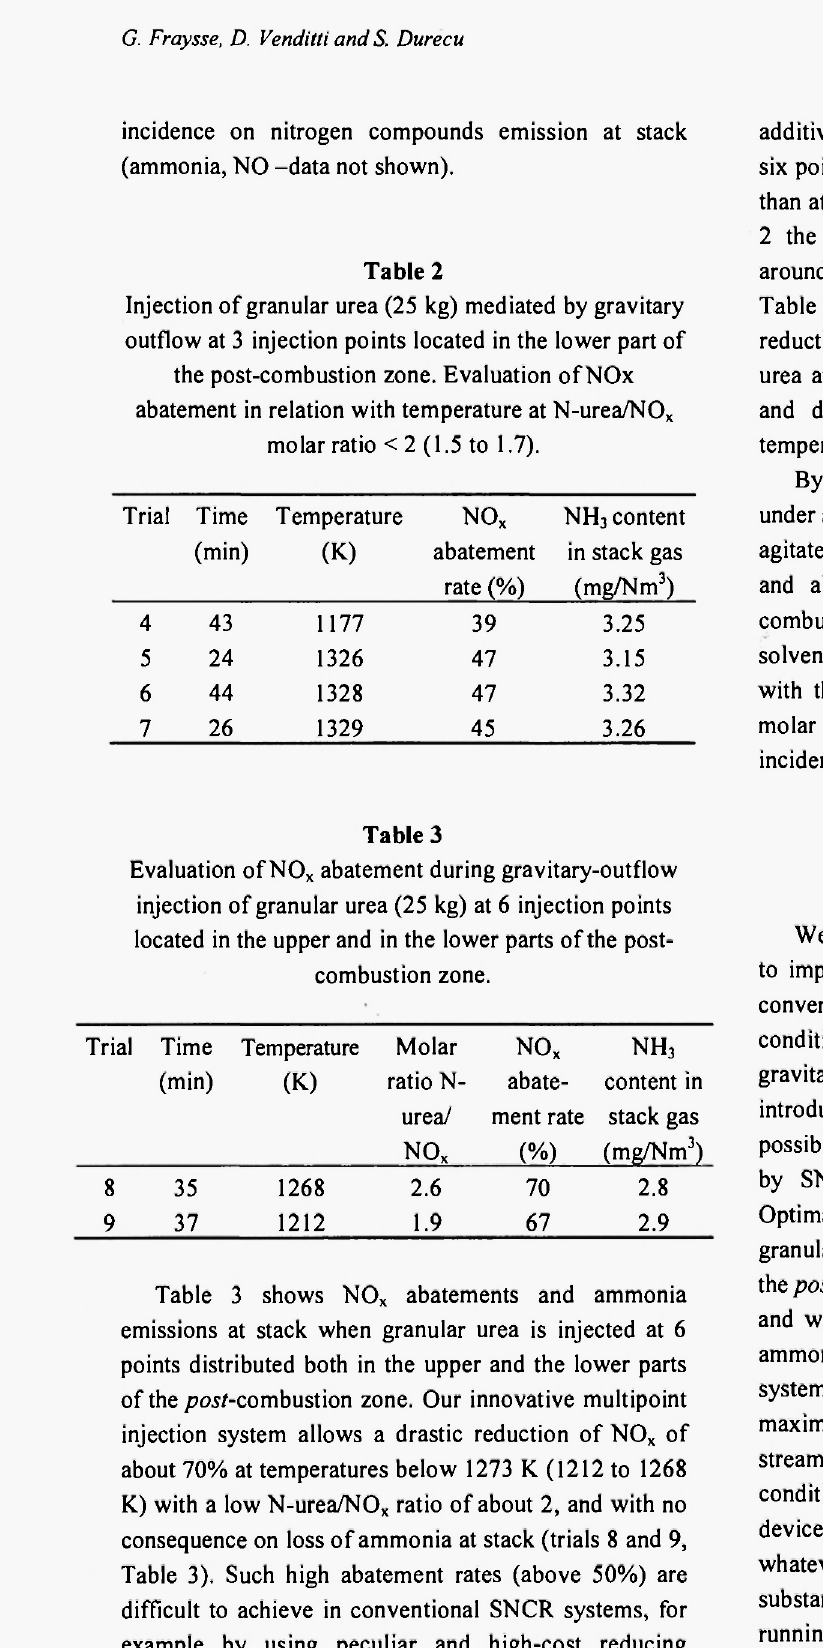
Evaluation of NO x abatement during gravitary-outflow injection of granular urea (25 kg) at 6 injection points located in the upper and in the lower parts of the